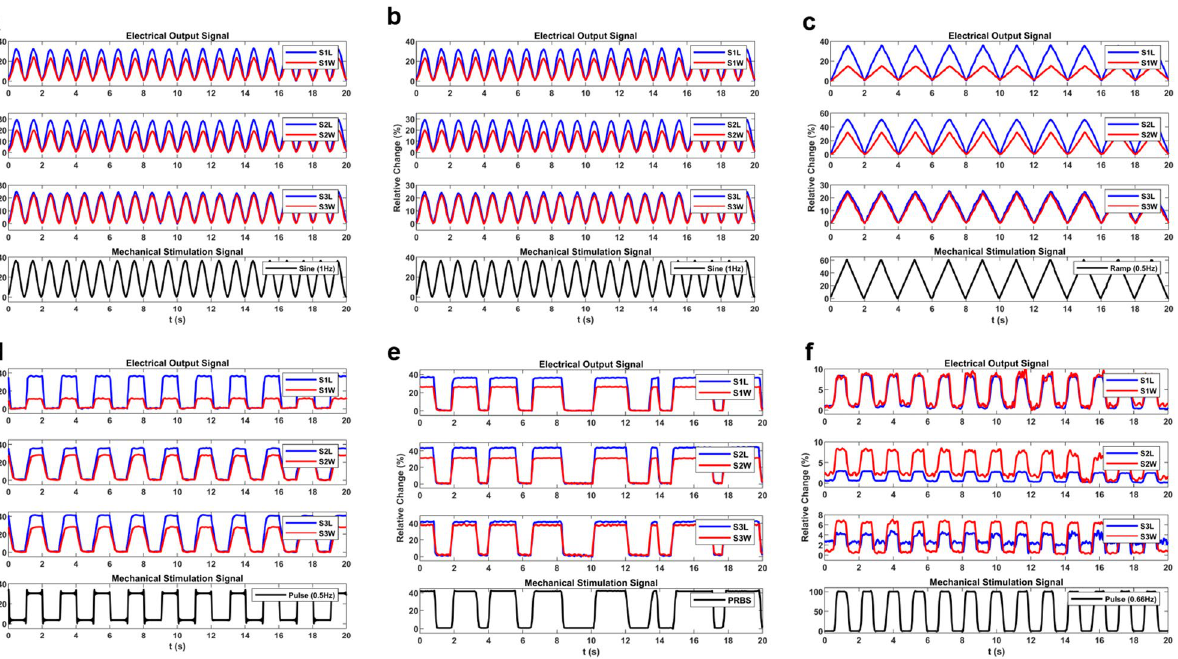
Figure 9. The Experimental output results of the electrical signal due to stretching with different mechanical signals of ( a ) and ( b ) sinusoidal, ( c ) ramp. ( d ) Pulse, and ( e ) PRBS mechanical signals. ( f ) Response of the soft sensors to the twist Pulse mechanical signal. Note : index i in SiW and SiL refers to Type-I sensors for i:1,2, and 3.